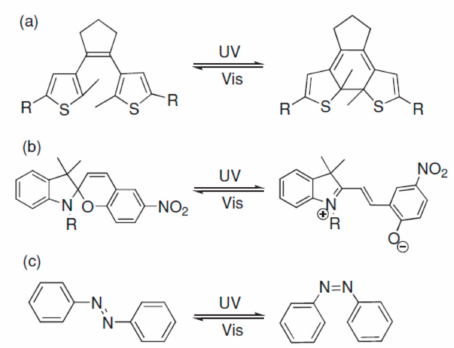
Figure 4. Photochromism of dithienylethene ( a ), spiropyran ( b ), and azobenzene ( c ). Reproduced from [53], WILEY-VCH: